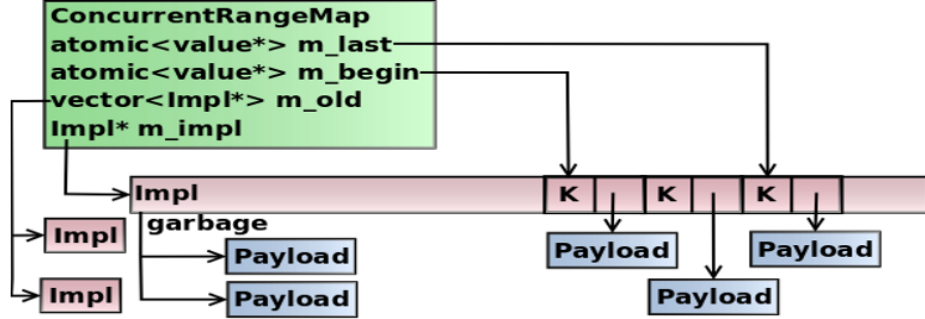
Figure 3. A ConcurrentRangeMap consists of a variable-sized implementation object containing a vector of pairs of time ranges and pointers to payload objects. Two atomic pointers delimit the range of valid entries. Old implementation objects are kept on a list to be deleted once no thread can any more be accessing them. Payload objects from deleted entries are put on a list in the implementation object to be deleted along with